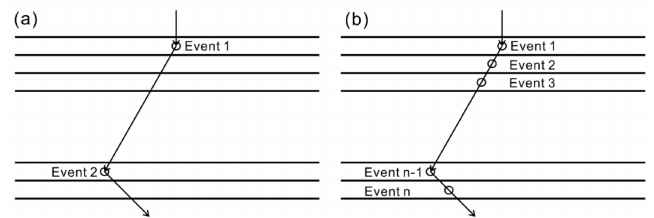
Figure 1. Problem formation using the Markov chain method. ( a ) Scattering-based model; ( b ) Time-based